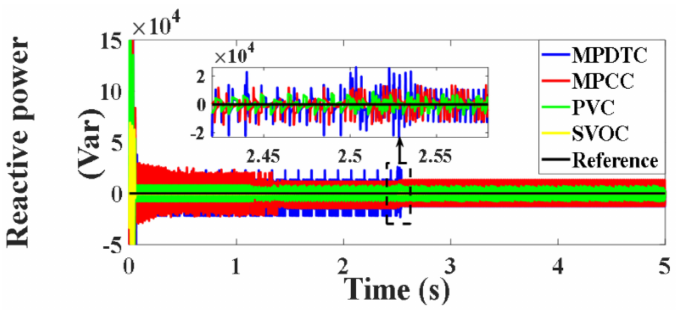
Figure 192. Comparison between reactive powers of four techniques (var).